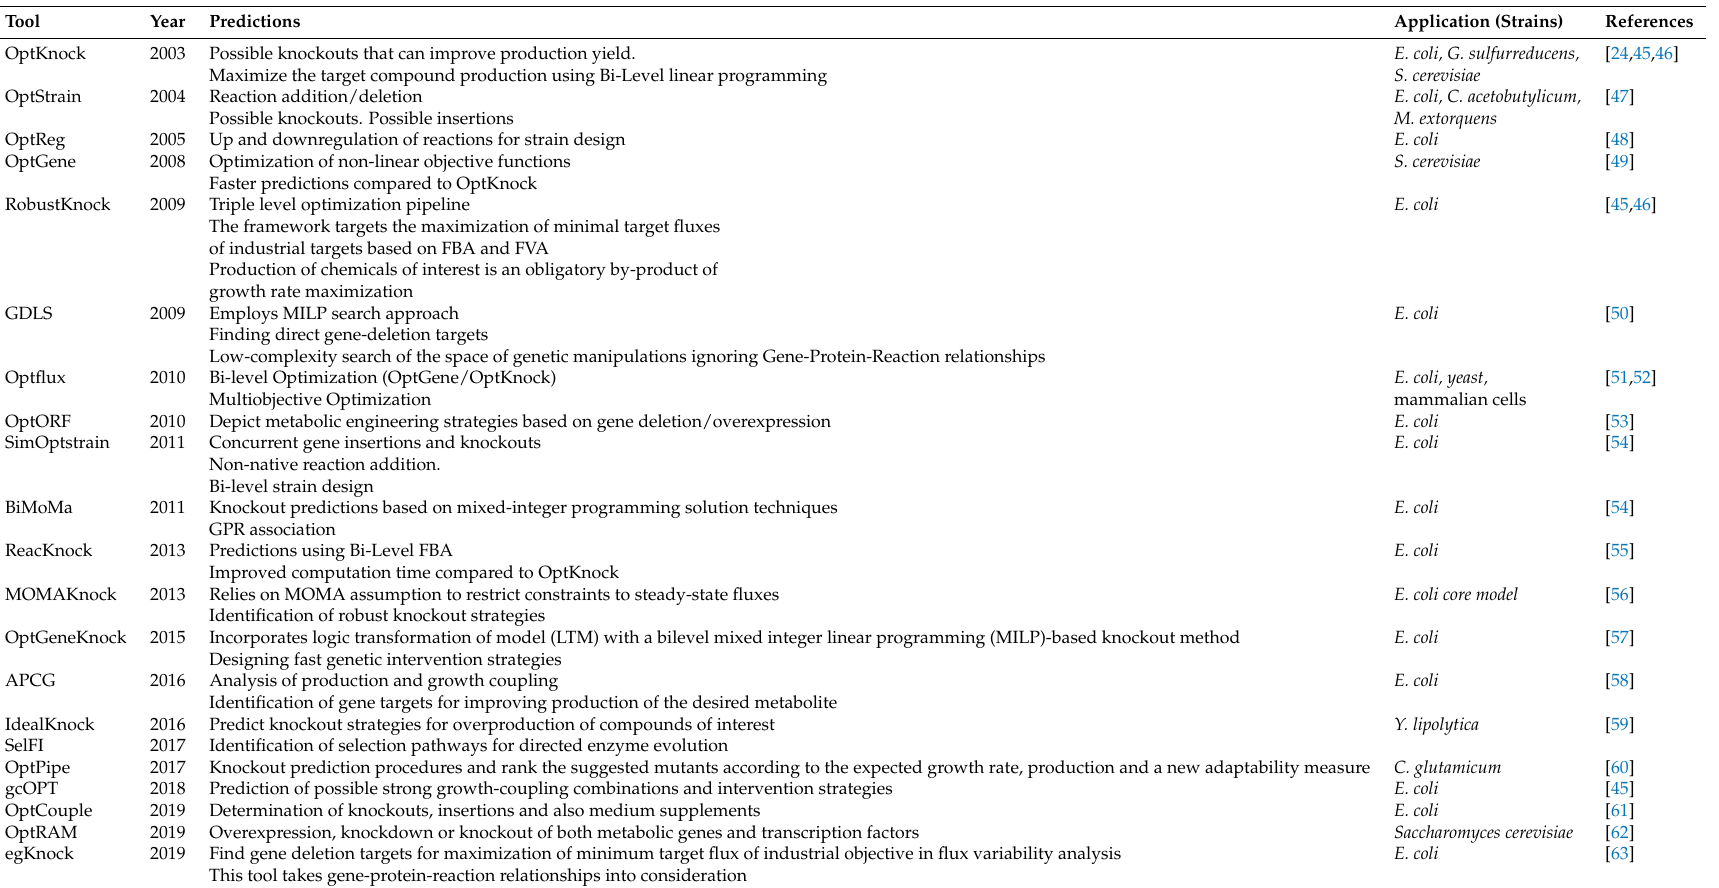
Table 1. Computational frameworks used for metabolic